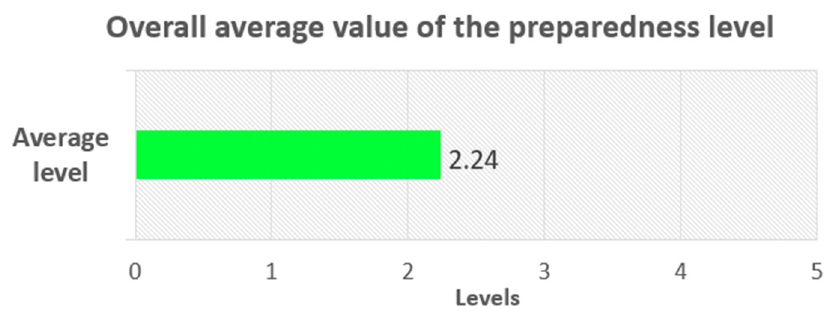
Figure 1. The total average value of enterprises’ preparedness